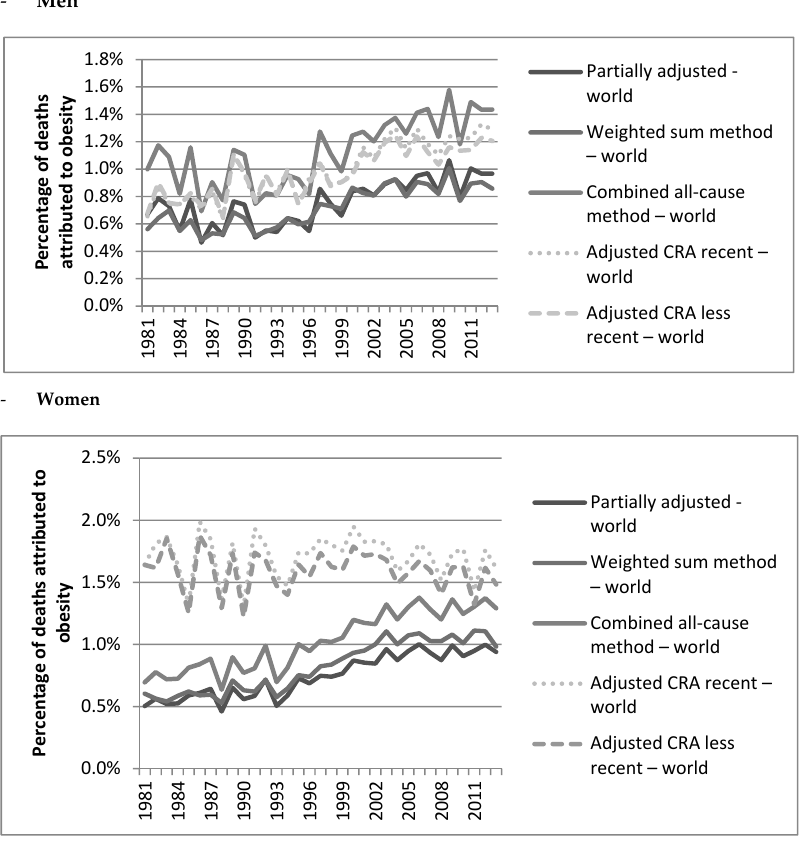
Figure 1. Estimates of the percentage of deaths attributed to obesity in The Netherlands using worldwide RRs from 1981 to 2013. Table 4. Percentage change in obesity-attributable mortality fractions (OAMF) from 1981–1993, 1993–2013, and 1981–2013 in The Netherlands by sex.